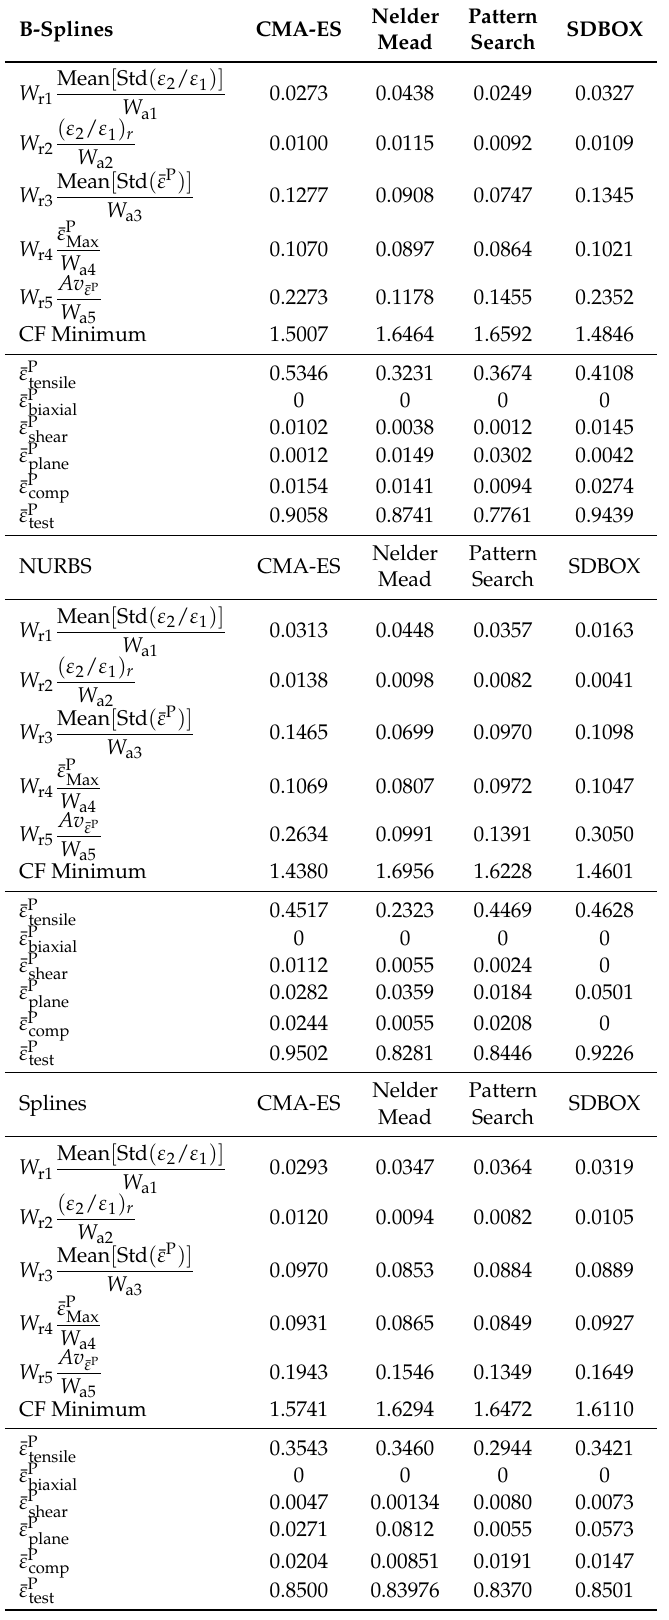
Table 6. Results for the mechanical test design using different optimization strategies and boundary curve